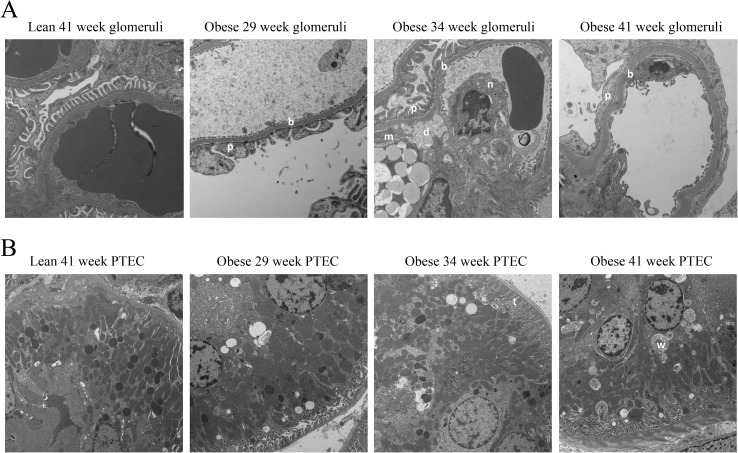
Nephropathy in obese ZSF1 rats is accompanied by ultrastructural changes in glomeruli and proximal tubular epithelial cells (PTEC).TEM of glomeruli (A) and PTEC (B) of a representative 41-week-old lean animal, and of representative 29-, 34-, and 41-week-old obese animals. Obesity and age-related findings were glomerular basement membrane thickening (b), podocyte foot process effacement (p), mesangial nodules (n) in glomerular capillary lumens, and increased mesangial matrix (m). Findings that were related to obesity, but not age, were glomerular lipid droplets (d) in mesangial cells, proximal tubular basement membrane thickening (t), and cytoplasmic membrane whorls (w). (Lead citrate/uranyl acetate, Magnification = 5,000x for A, and 2,000x for B).